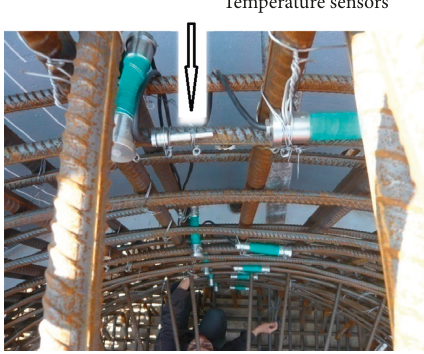
Figure 3: In situ installation of the temperature